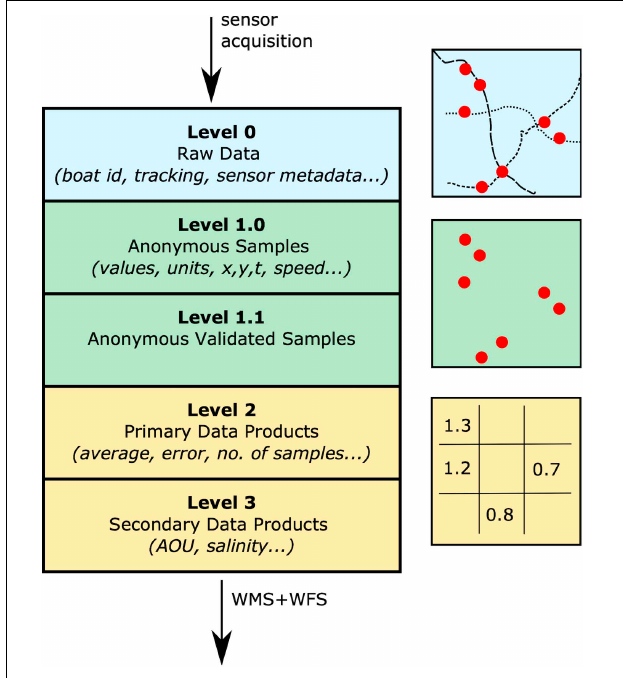
FIGURE 13 | Production workflow of the MaDCrow project. From level 0 to level 3 raw data is transformed into statistically validated environmental quality indicators such as the Apparent Oxygen Utilization